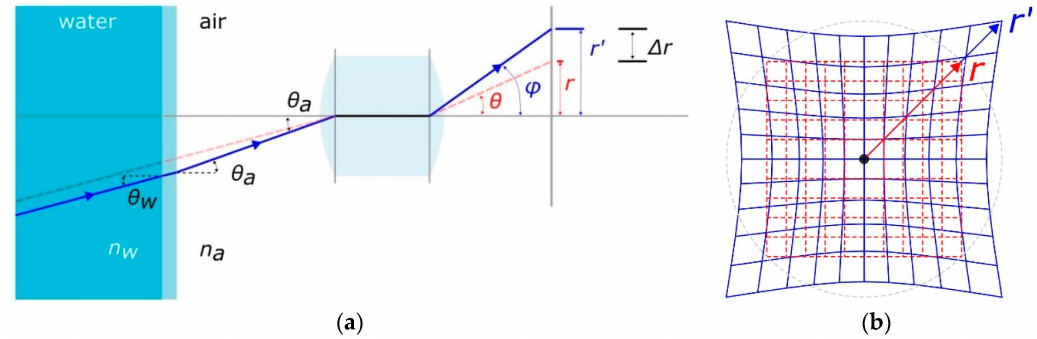
Figure 4. Effect of a flat port on image distortion: ( a ) section view; ( b ) image plane view.